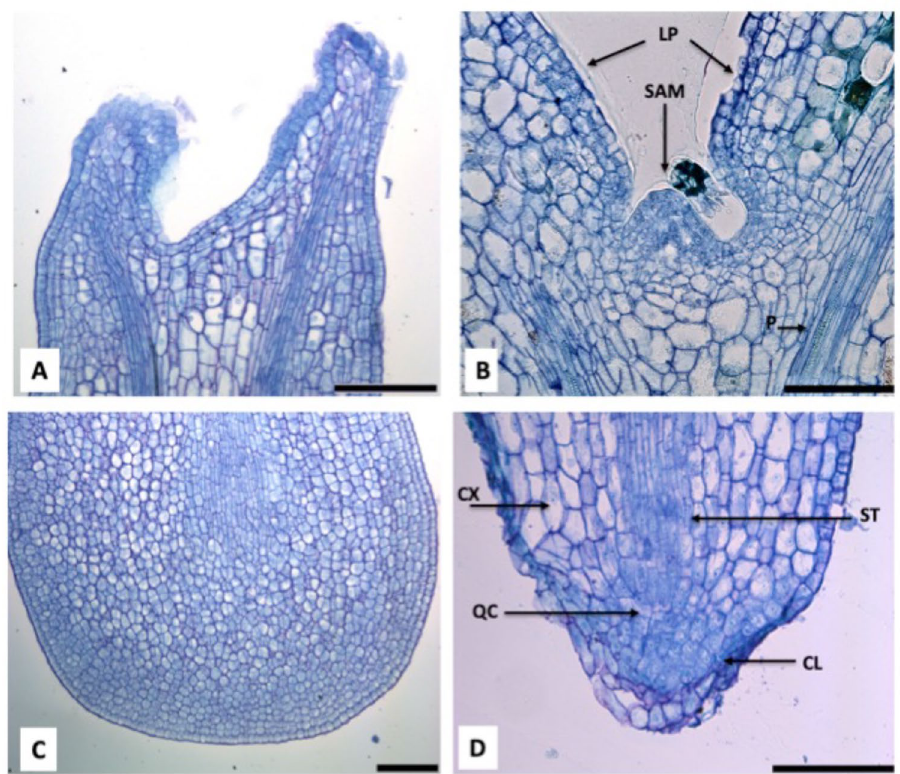
Figure 3. Histological analysis of SEs induced by non-osmotic stress ( A and C ) and by osmotic stress ( B and D ). ( A ) SEs at cotyledonary stage derived from SE-M3, notice that SAM is not well developed. Bar indicates 100 μm. ( B ) SEs at cotyledonary stage derived from SE-M9 treatment, notice that SAM is well developed. Bar indicates 100 μm. ( C ) SEs at cotyledonary stage derived from SE-M3 treatment, notice that RAM is not developed. Bar indicates 100 μm. ( D ) SEs at cotyledonary stage derived from SE-M9 treatment, notice that RAM is well developed. SAM, shoot apical meristem, LP, leaf primordium. Root apical meristem (RAM). CL, columella, ST, stella, CX, cortex, QC, quiescent center. Bar indicates 100